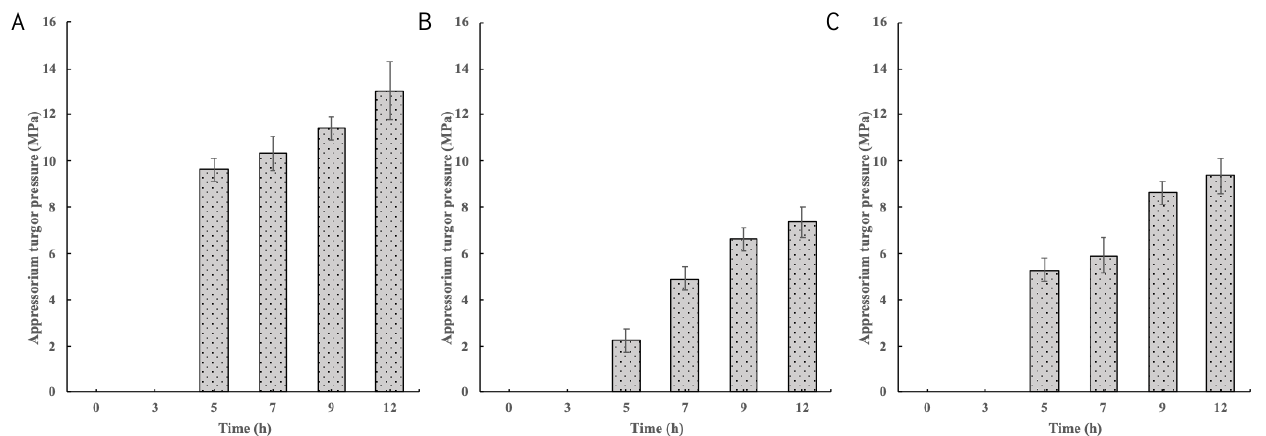
Figure 2. Appressorium turgor pressure for the wild-type (WT) control ( A ) and Δ CgCmr1 ( B ) and Δ CgPks1 ( C ) mutants at different time points.